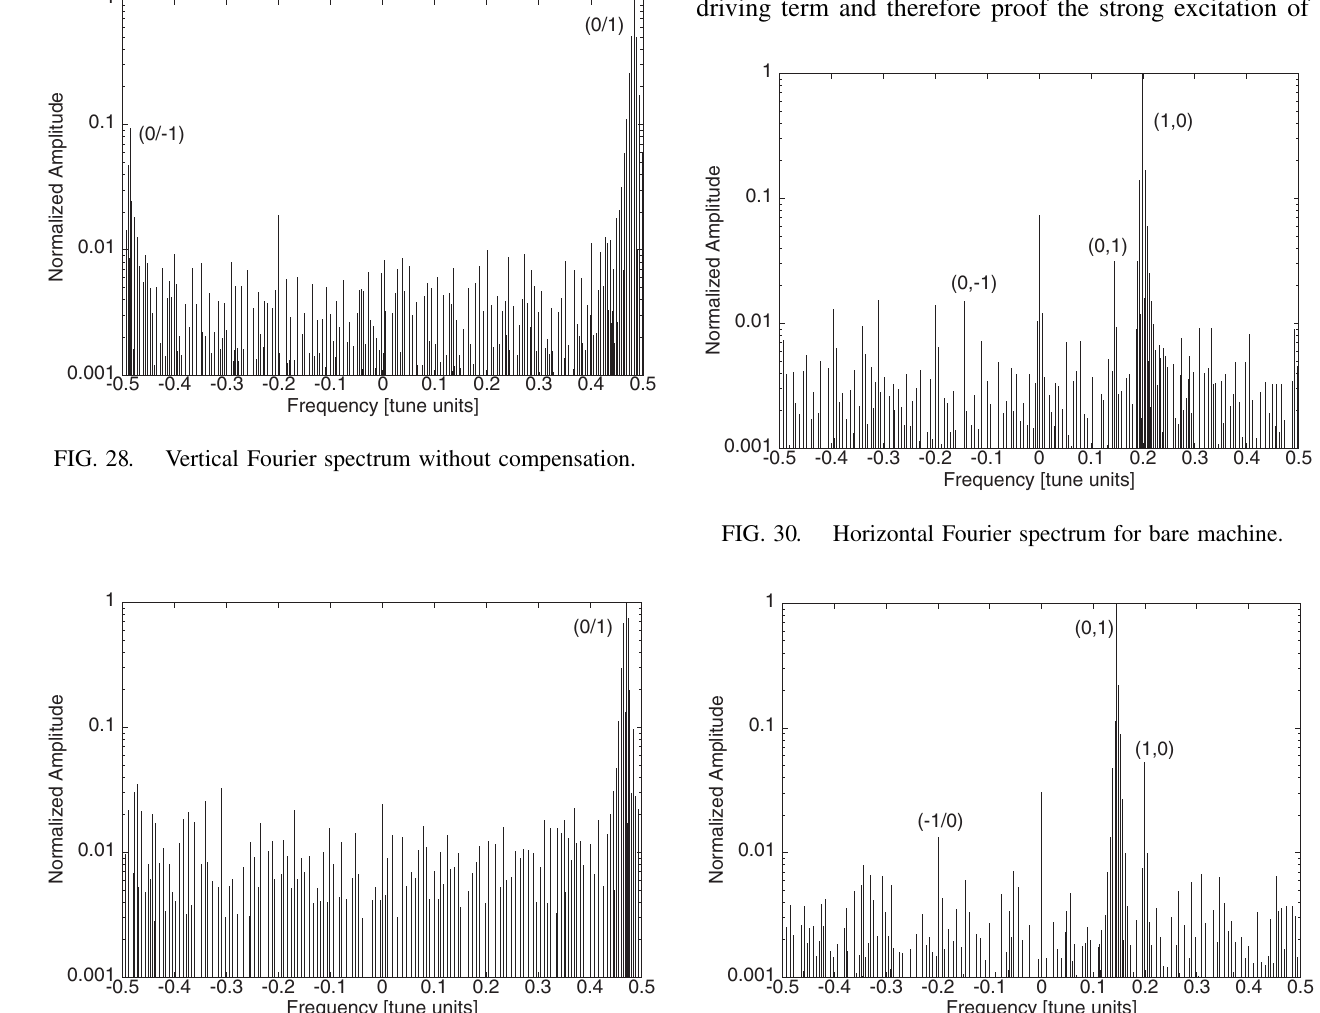
FIG. 31. Vertical Fourier spectrum for bare machine.